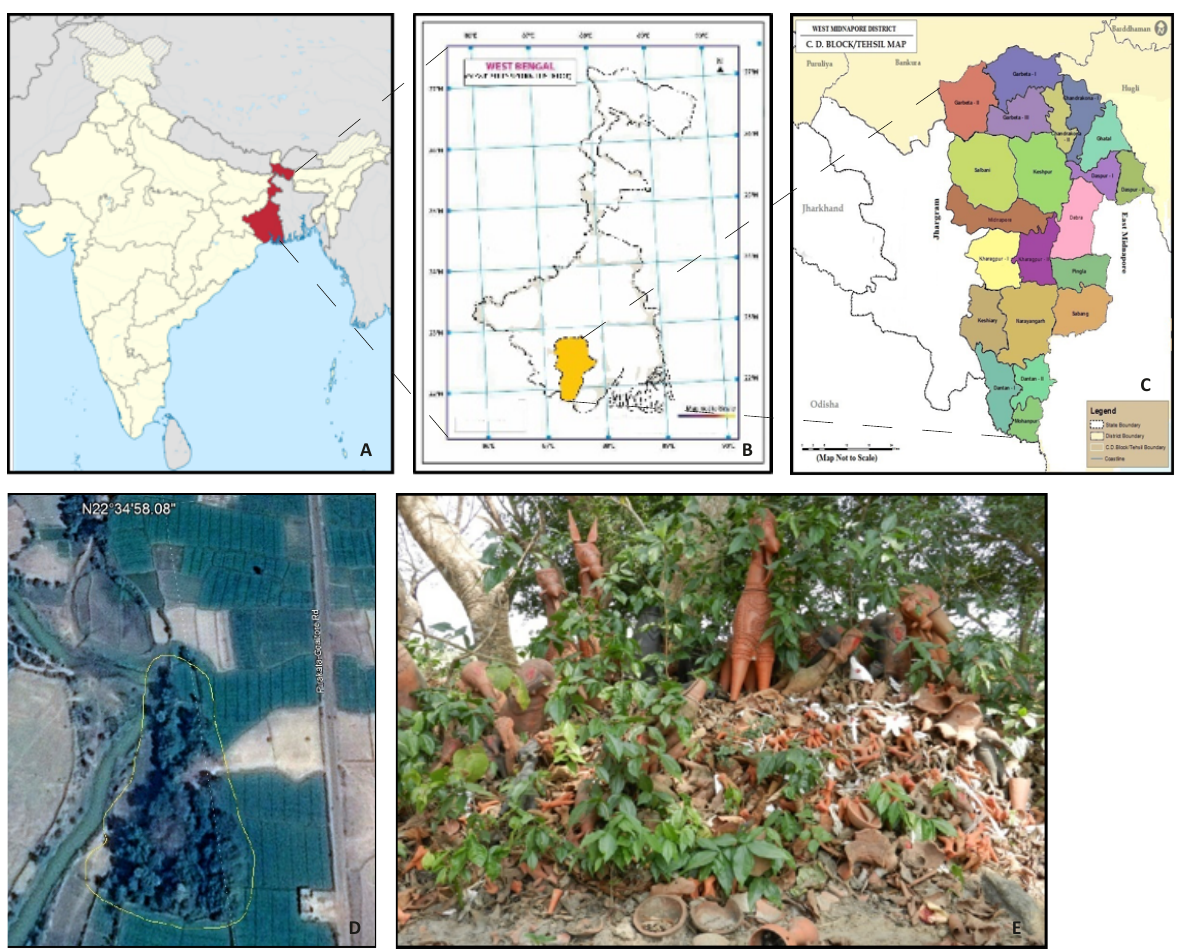
Figure 1. The study area: A -India, B - West Midnapore District in West Bengal, C - Salboni block in West Midnapore District, D - Joypur Joysini Matar Than sacred grove (Google image), E - Deity Joysini Mata inside the